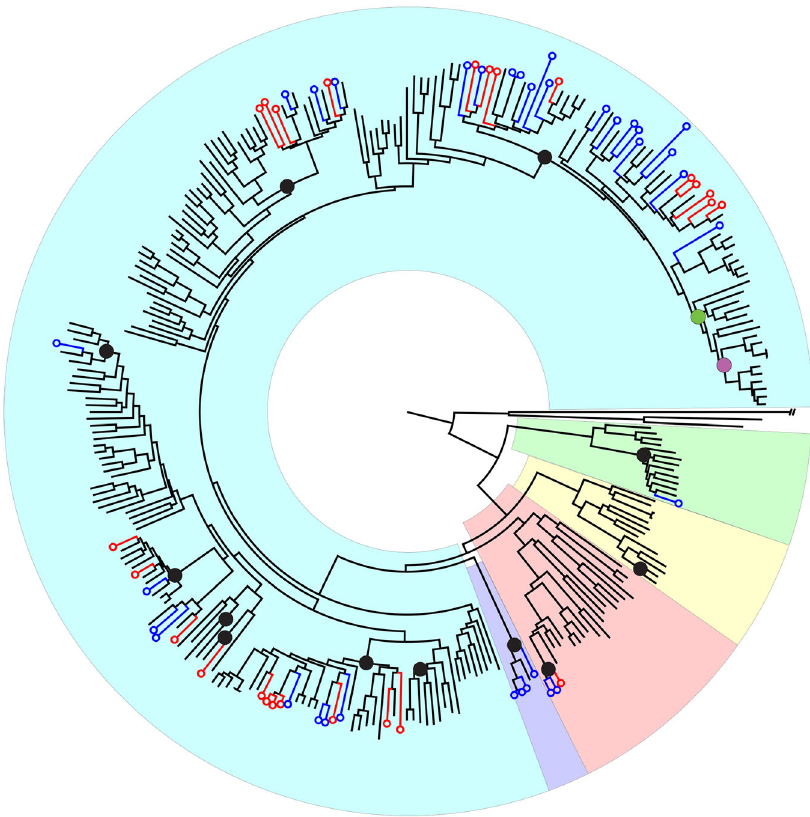
Fig.2|Phylogenetictreebasedonsinglenucleotidepolymorphismsamongall 292 resequenced Myrtaceae accessions. Black circles represent the at-least 12 independent invasions ofSundafrom Sahul. The greencircle representsmigration from Sunda to the Indian subcontinent, and the purple circle denotes further migration from there to Africa. Blue versus red circles at the leaves of the tree